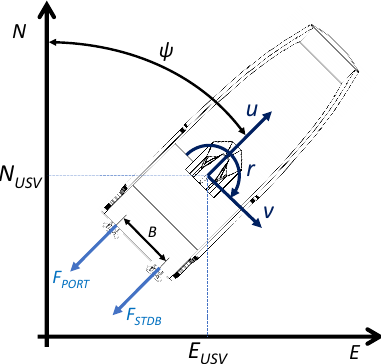
Figure 1. Simplified model of the unmanned surface vehicle (USV) using the North-East-Down (NED) coordinate system. USV motion is described by surge u (linear longitudinal motion), sway v (linear transverse), and yaw motion r (turning rotation about its